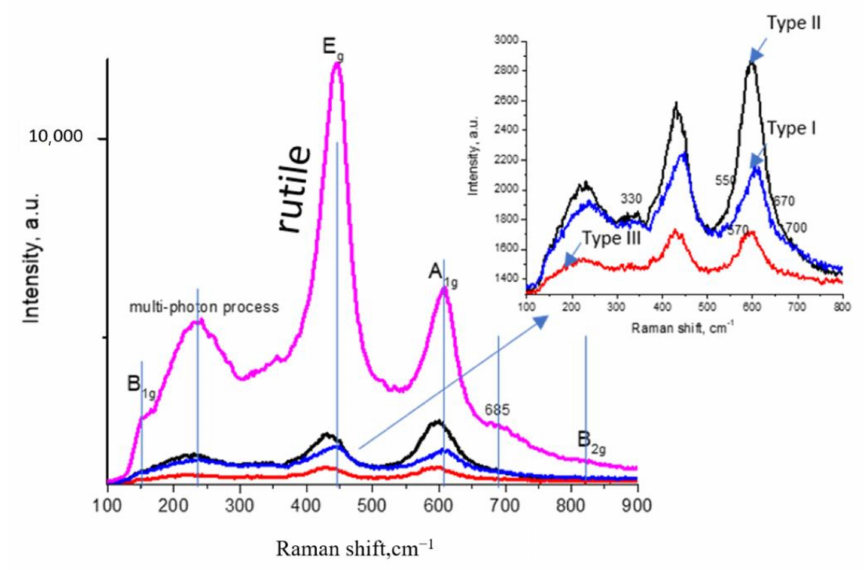
Figure 3. Raman spectrum of the samples of types I, II, and III.